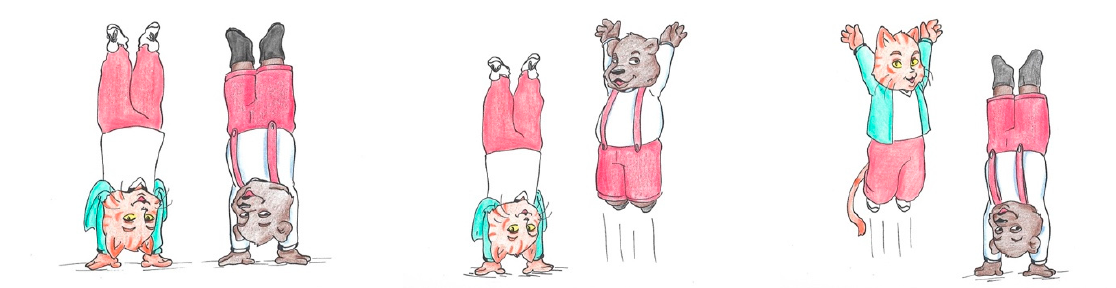
Figure A29. Filler stimulus 4.